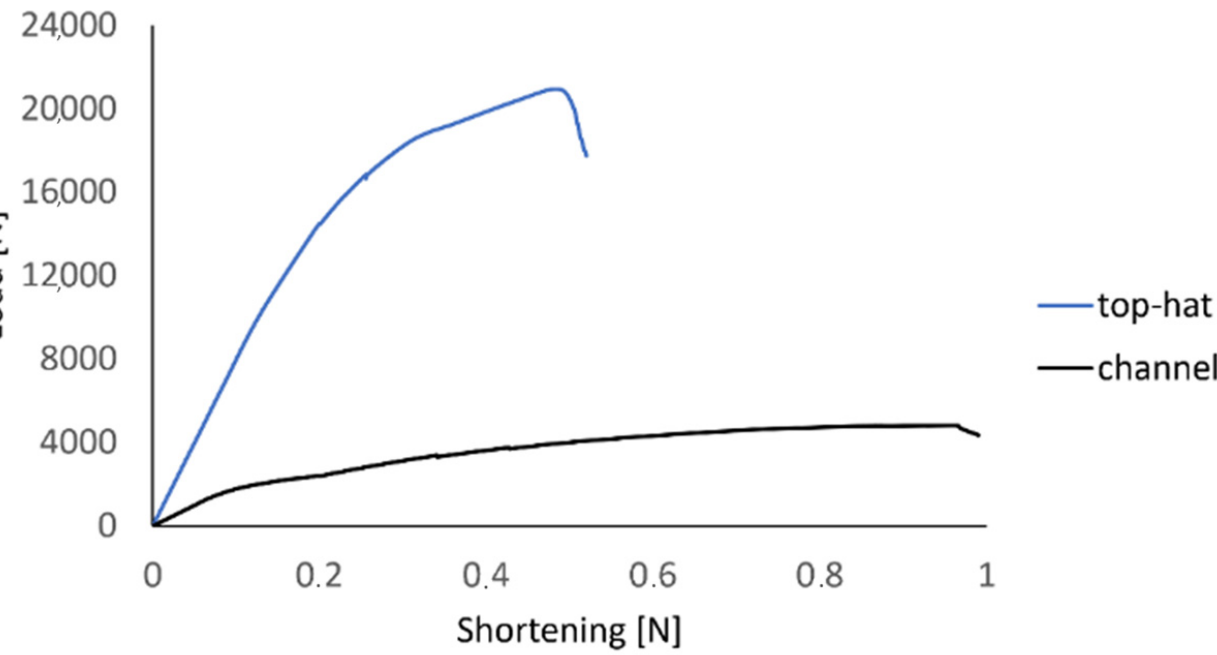
Figure 7. The evolution of delamination (CZM): ( a ) top-hat column, ( b ) channel column.